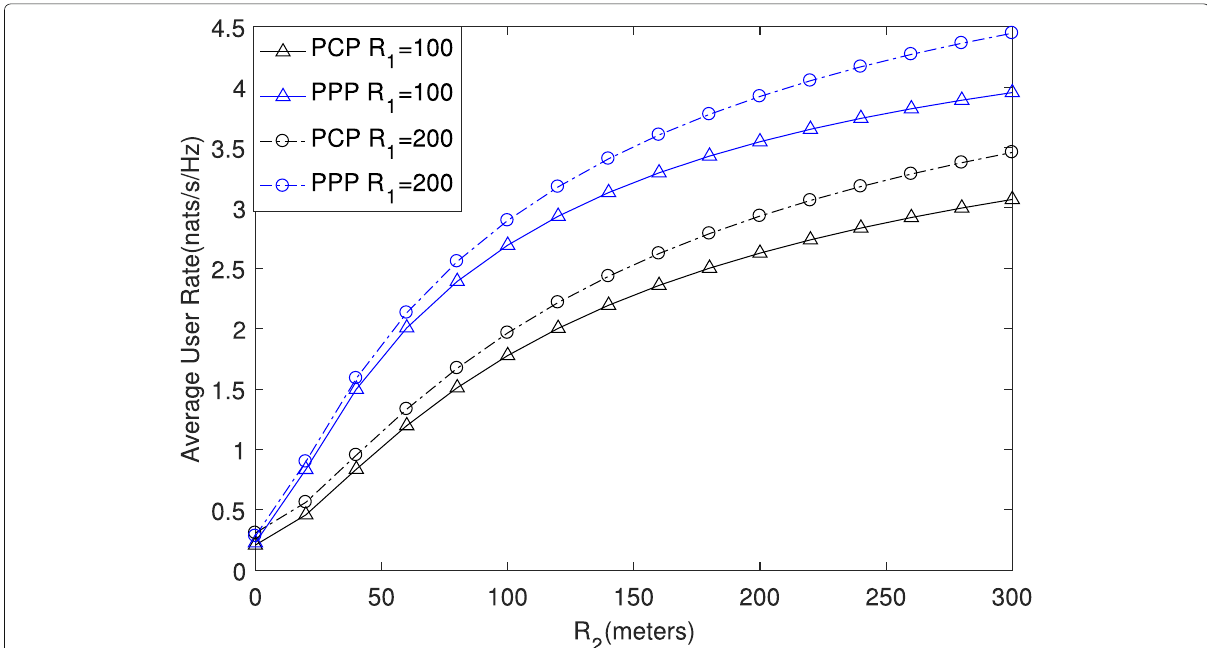
Fig. 5 The average user rates of PPP model and PCP model as a function of the second-tier cooperative radius R 2 with two different cooperative radii of the first